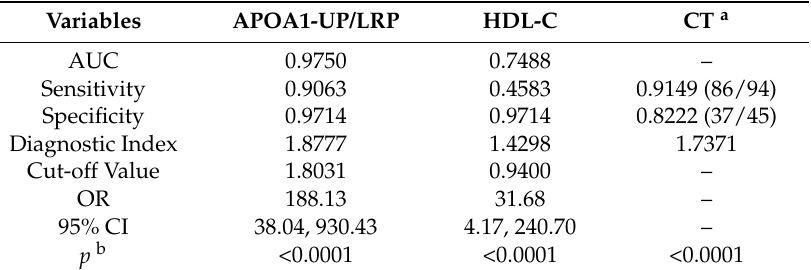
Table 4. Evaluation of APOA1-UP/LRP, HDL-C, and initial CT scan as diagnostic tests for acute ischemic